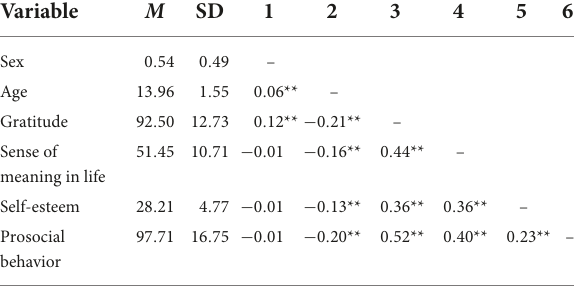
TABLE 1 Mean, standard deviation, and correlation coefficient for each